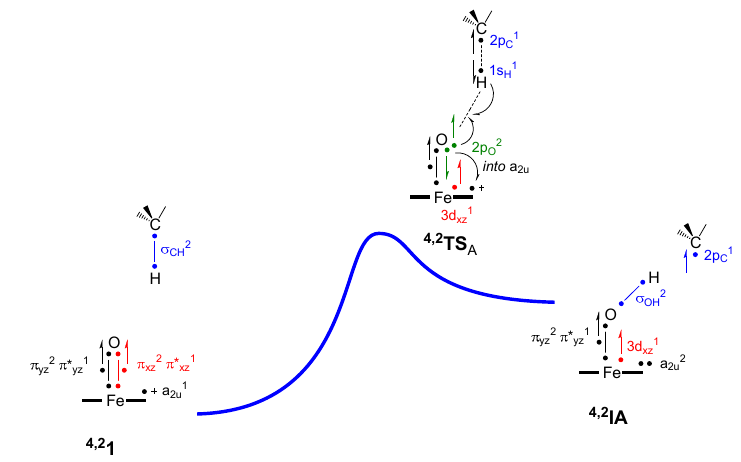
Figure 9. Valence bond description of hydrogen atom abstraction from the substrate. Dots represent electrons and a line between two dots is a bond with two electrons.